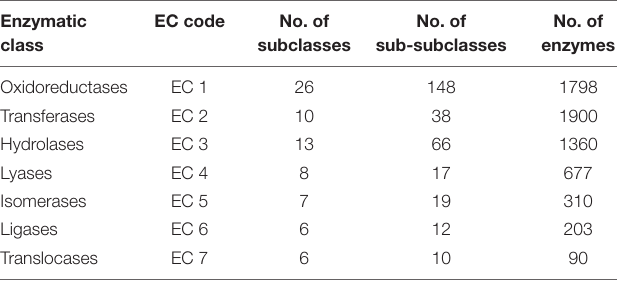
TABLE 1 | Number of subcategories and entries for each enzymatic